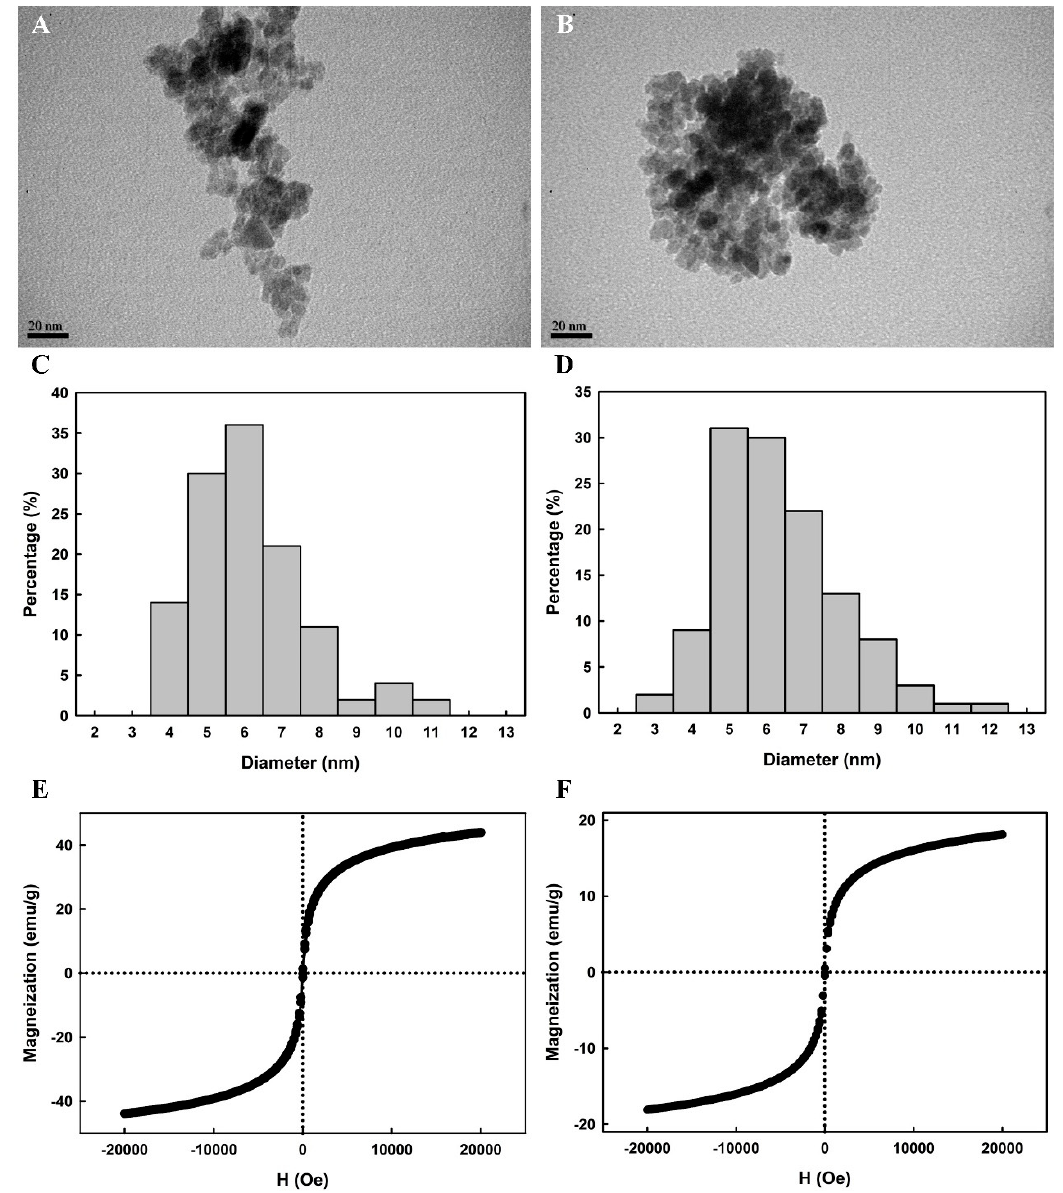
Figure 3. TEM micrographs ( A , B ), particle size distributions ( C , D ), and magnetization curves ( E , F ) of